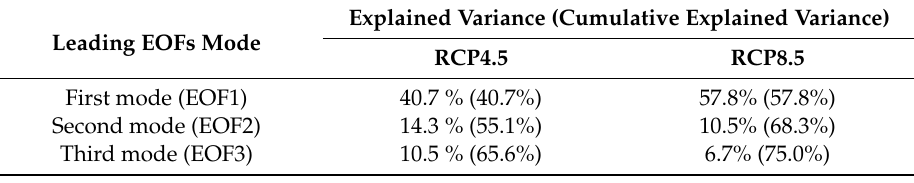
Table 2. Explained variance of the leading EOFs of the annual SPEI.